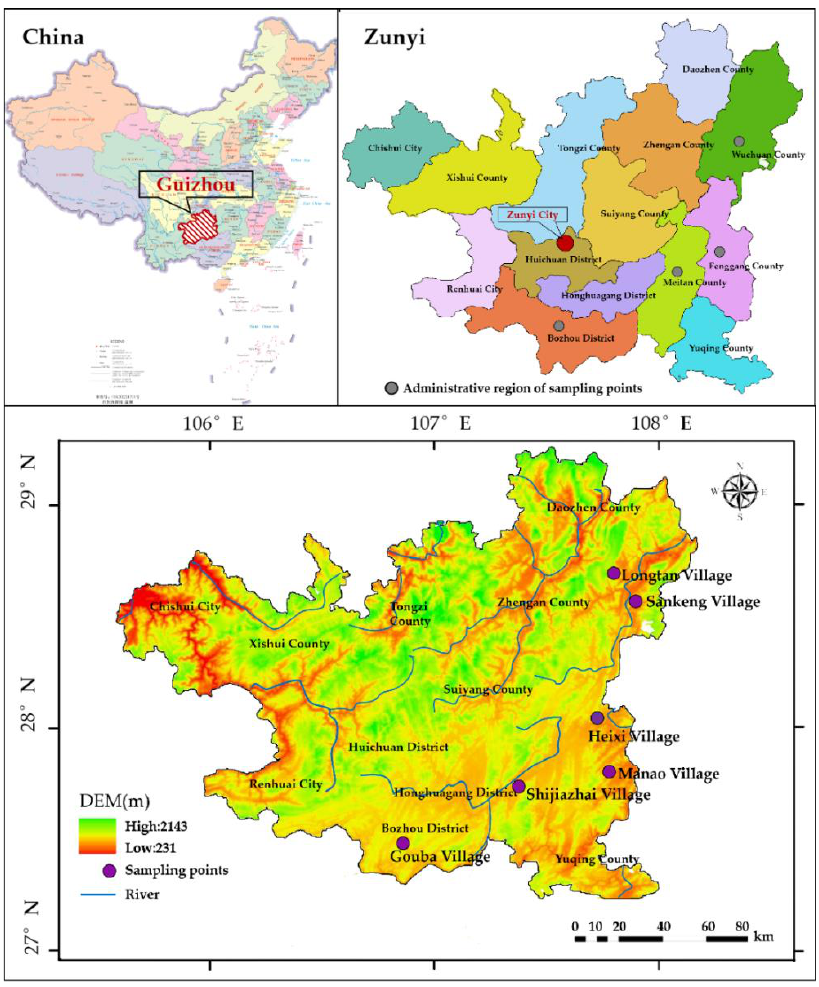
Figure 1. Study area and six traditional villages distribution.